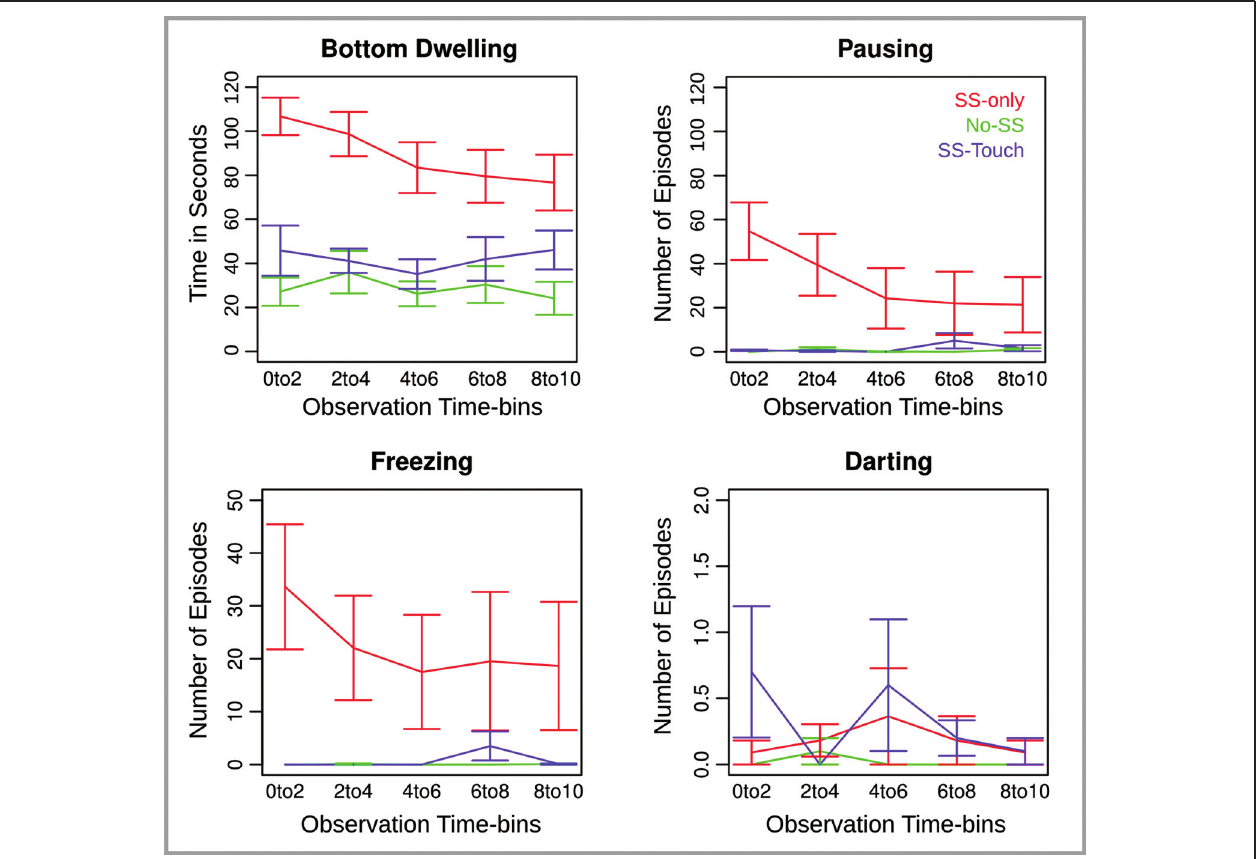
FIGURE 1 | Behavioral measures for Experiment 1 across five consecutive 2 min observation time bins . Error bars reflect the standard error of the mean.